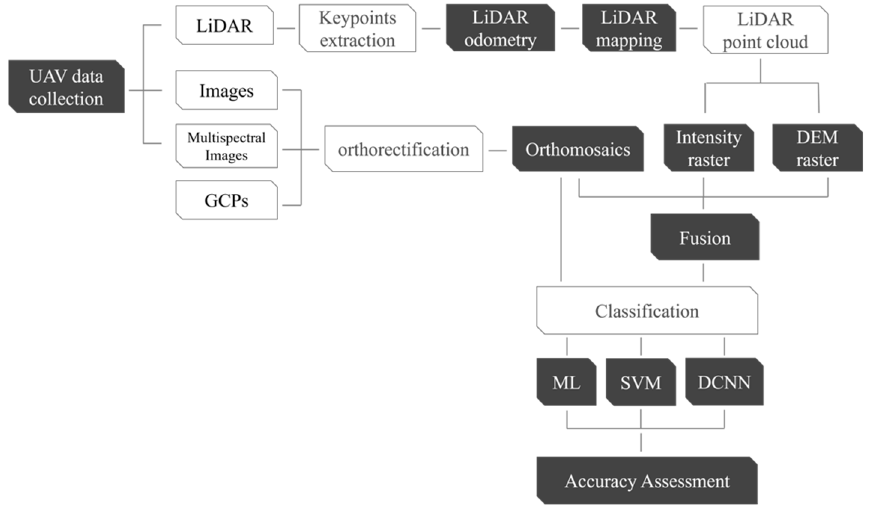
Figure 1. Workflow of the proposed methodology.